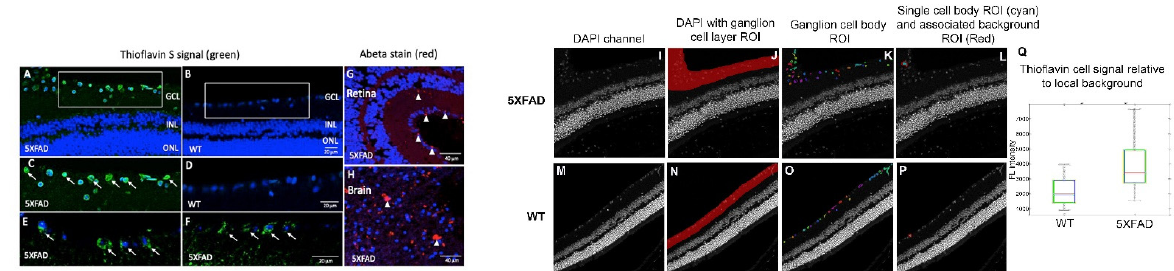
Figure 3. Imaging retinal Abeta using inhalable ThioS and corroboration with Abeta immunohistochemistry in the retina and brain. Fluorescence imaging of retinal cross-sections of 5XFAD ( A ) and WT controls ( B ) after ThioS inhalation. Higher magnifications of boxed areas in ( A , B ) are shown in ( C , D ). Arrows point to ThioS-labeled RGCs. Additional examples are shown in ( E , F ) of 5XFAD retina after ThioS inhalation. The retina ( G ) and brain (cerebral cortex) ( H ) of a 5XFAD mouse after immunohistochemical detection of Abeta. Red immunoreactivity is seen in small deposits in GCL and inner plexiform layer (IPL) of the retina and in plaques in the brain (arrowheads). Green (488 nm) channel demonstrates ThioS fluorescence; red (546 nm) channel depicts Abeta immunohistochemsitry; blue (405 nm) depicts DAPI labeling for nuclei. GCL = ganglion cell layer. INL = inner nuclear layer. ONL = outer nuclear layer. On the DAPI image ( I , M ), the ganglion cell layer was segmented manually ( J , N ). Then, an Otsu’s method threshold followed by a dilation/erosion step was used to identify cell body ROIs ( K , O ). The non-cell body pixel within 20 pixels of each cell body ROI was used for a measure of local background intensity (example for a single ROI in L , P ). Then, applying the ROIs to the ThioS images, the mean intensity of local background pixels was subtracted from the mean intensity of each cell body ROI. The results for all cells are summarized in the boxplot for a 5XFAD ( I – L ) and a WT ( M – P ) mouse. Values for all cell body ROIs ( Q ).